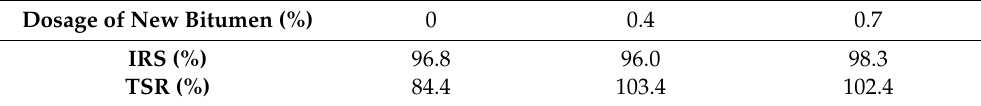
Table 5. Effects of new bitumen on the water damage resistance of BRA-rejuvenated RAP. Dosage of New Bitumen (%) 0